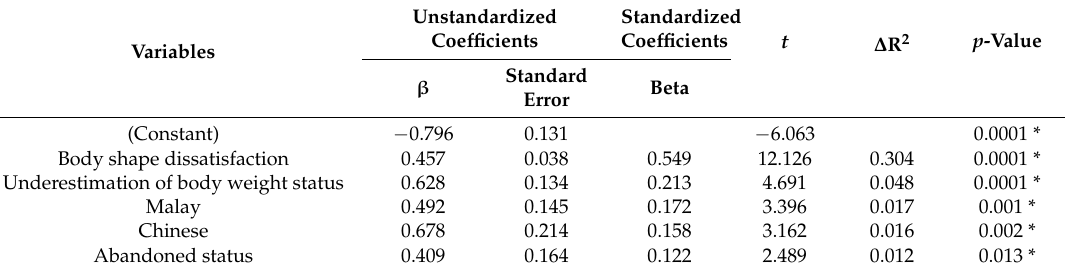
Table 4. Multiple linear stepwise regression of BMI-for-age ( z -score) ( N =